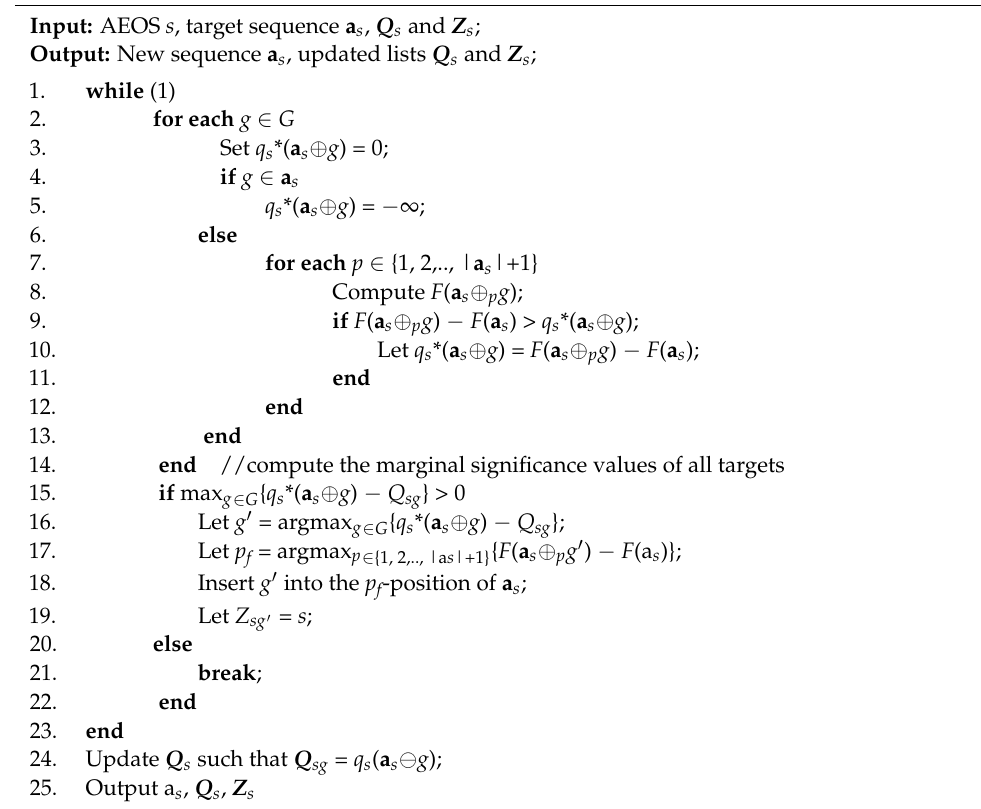
Algorithm 4 : Task inclusion phase running on each